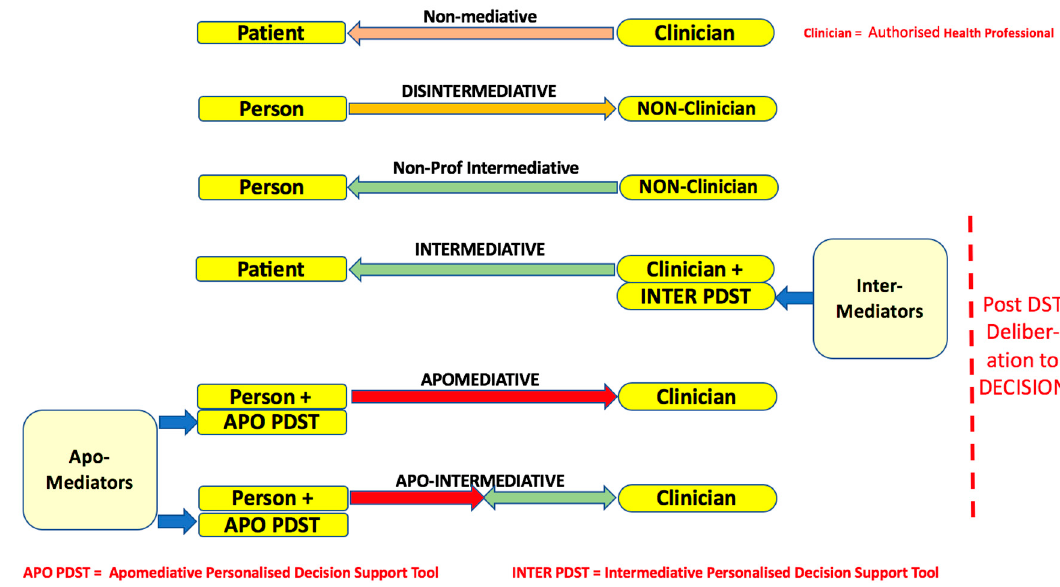
Figure 1. Taxonomy of alternative types of disintermediation, apomediation and intermediation.